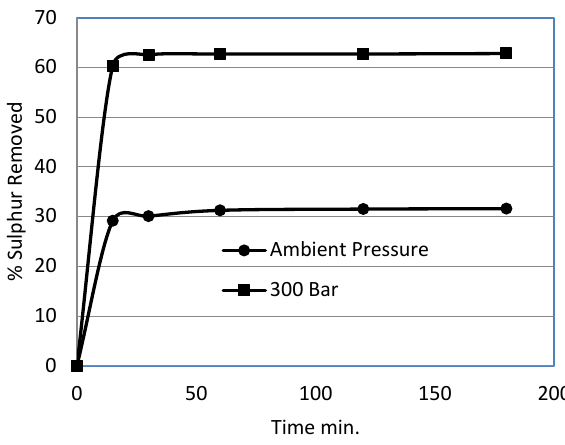
Figure 14. Effect of time on organic sulphur removal.